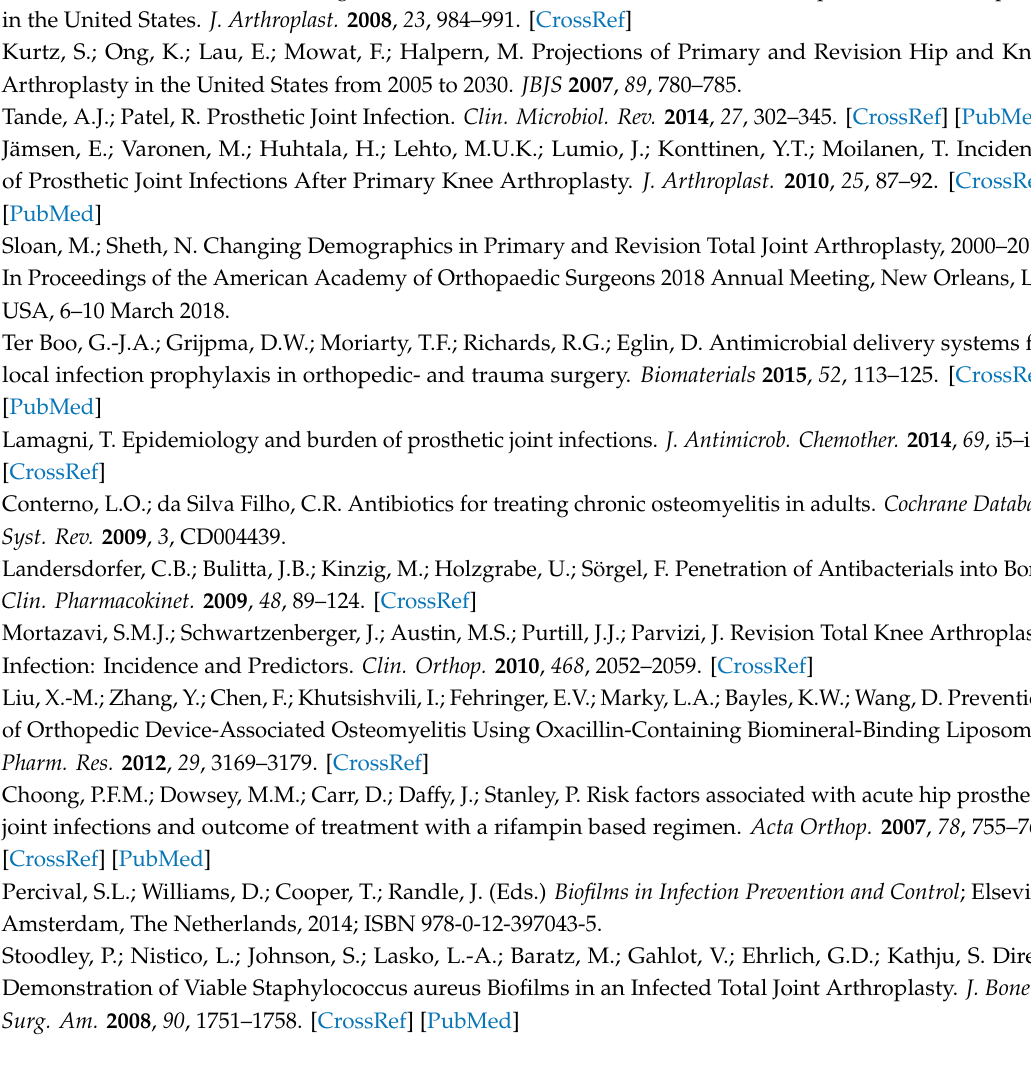
Figure S1: The zone of inhibition study done with released drug in 2 mL and 5 mL release media showed similar antibacterial activity against S. aureus (ATCC 49230), Figure S2: The zone of inhibition study was done with (a) vancomycin and (b) rifampicin standards to see activity against S. aureus (ATCC 49230). For vancomycin, concentration of ≥ 0.5 µ g / mL showed ZOI indicating antibacterial activity. For rifampicin, concentration of ≥ 0.031 µ g / mL showed ZOI indicating antibacterial activity, Figure S3: The x-ray images of cohort 1 rat tibia (control group rat in drill-hole model). Bone with osteomyelitis is